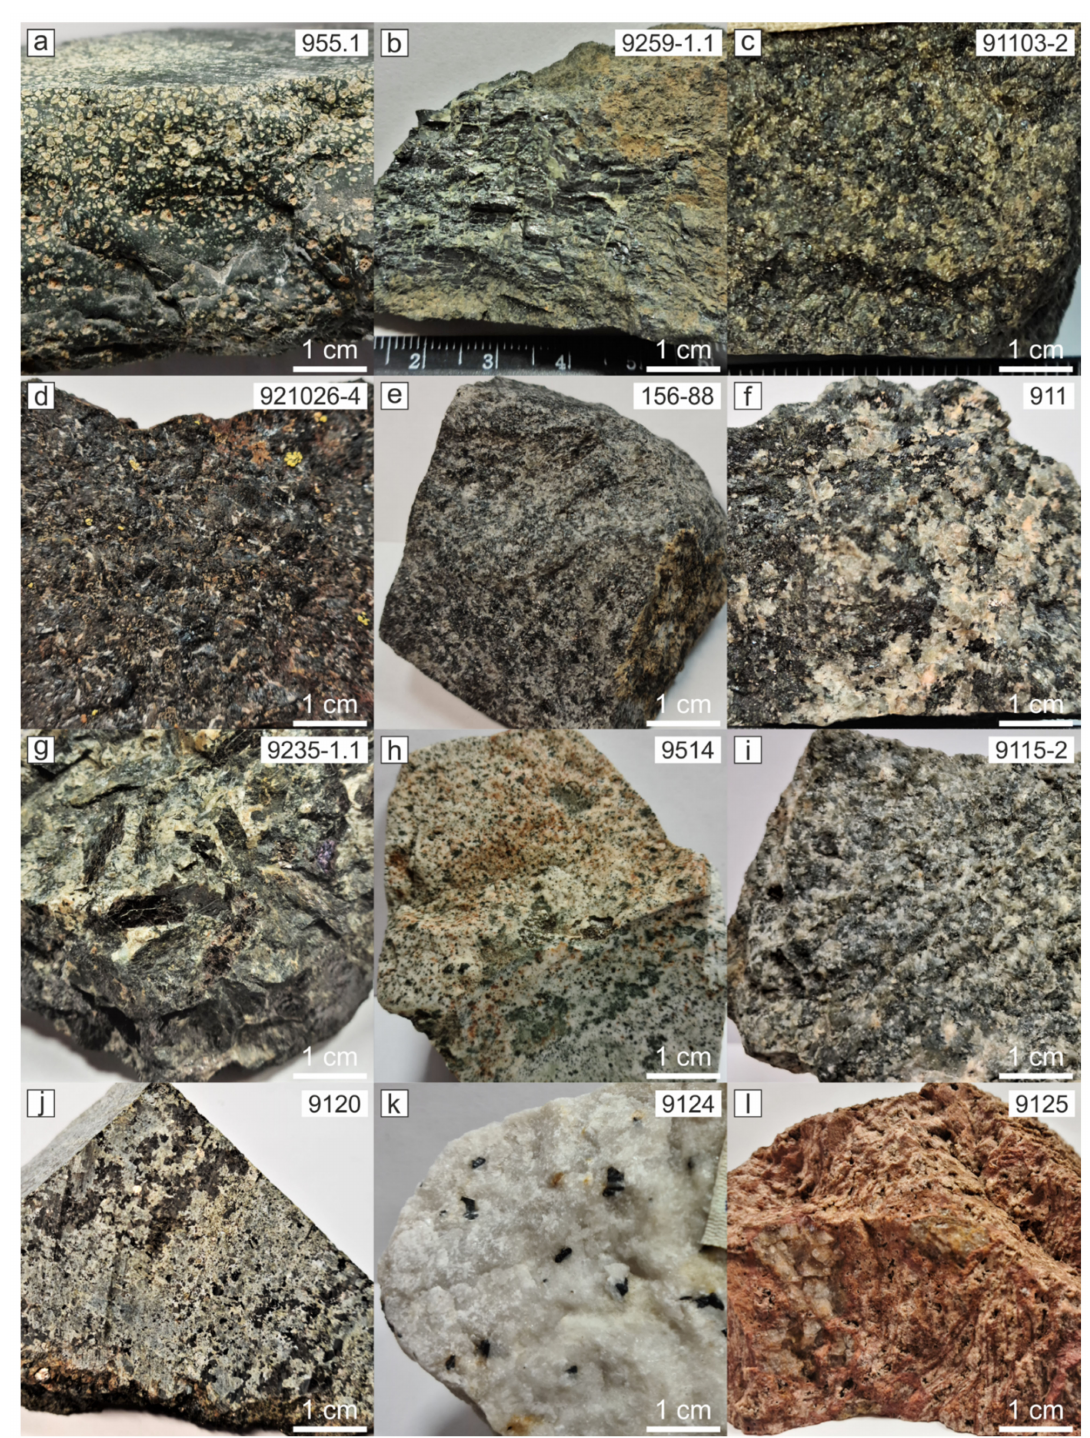
Figure 2. Photographs of the main rock varieties: ( a ) meimechite; ( b ) dunite with chromite schlier; ( c ) ore wehrlite; ( d ) ore pyroxenite; ( e ) kugdite; ( f ) ijolite-melteigite; ( g ) coarse-grained shonkinite; ( h ) alkaline microsyenite; ( i ) foyaite; ( j ) magnetite-apatite-diopside rock; ( k ) calcite carbonatite; ( l ) dolomite